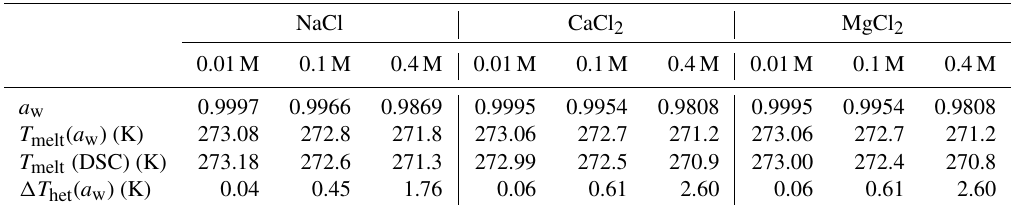
Table 6. Water activities ( a w ) of the salt solutions calculated with AIOMFAC (Zuend et al., 2008, 2010); melting temperatures, T melt ( a w ), calculated as a function of a w with the parameterization by Koop et al. (2000) in comparison with the measured melting temperatures T melt (DSC) (average of quartz and microcline samples at all pH values), and corresponding freezing point depression as a function of a w derived with T het ( a w ) = T melt ( a w + (cid:49)a w , het ), with (cid:49)a w , het = 0 . 2 (Zobrist et al., 2008). NaCl CaCl 2 MgCl 2 0.01M 0.1M 0.4M